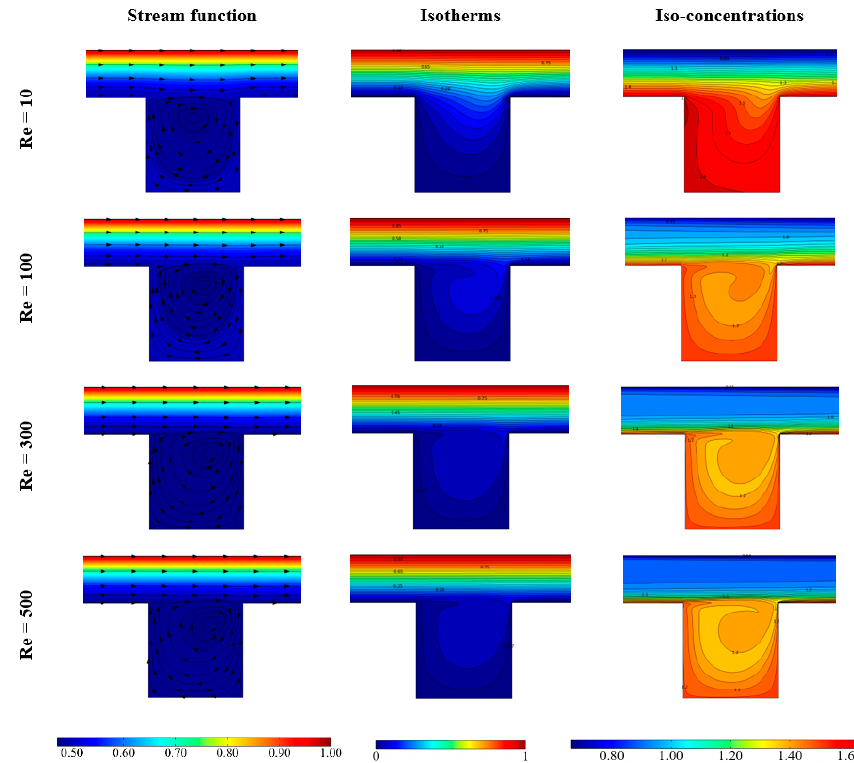
Figure 3. Stream function, Isotherms and Iso-concentration for various Reynolds number and Pr = 6.2, Le = 1, N B = N T = 0.1.